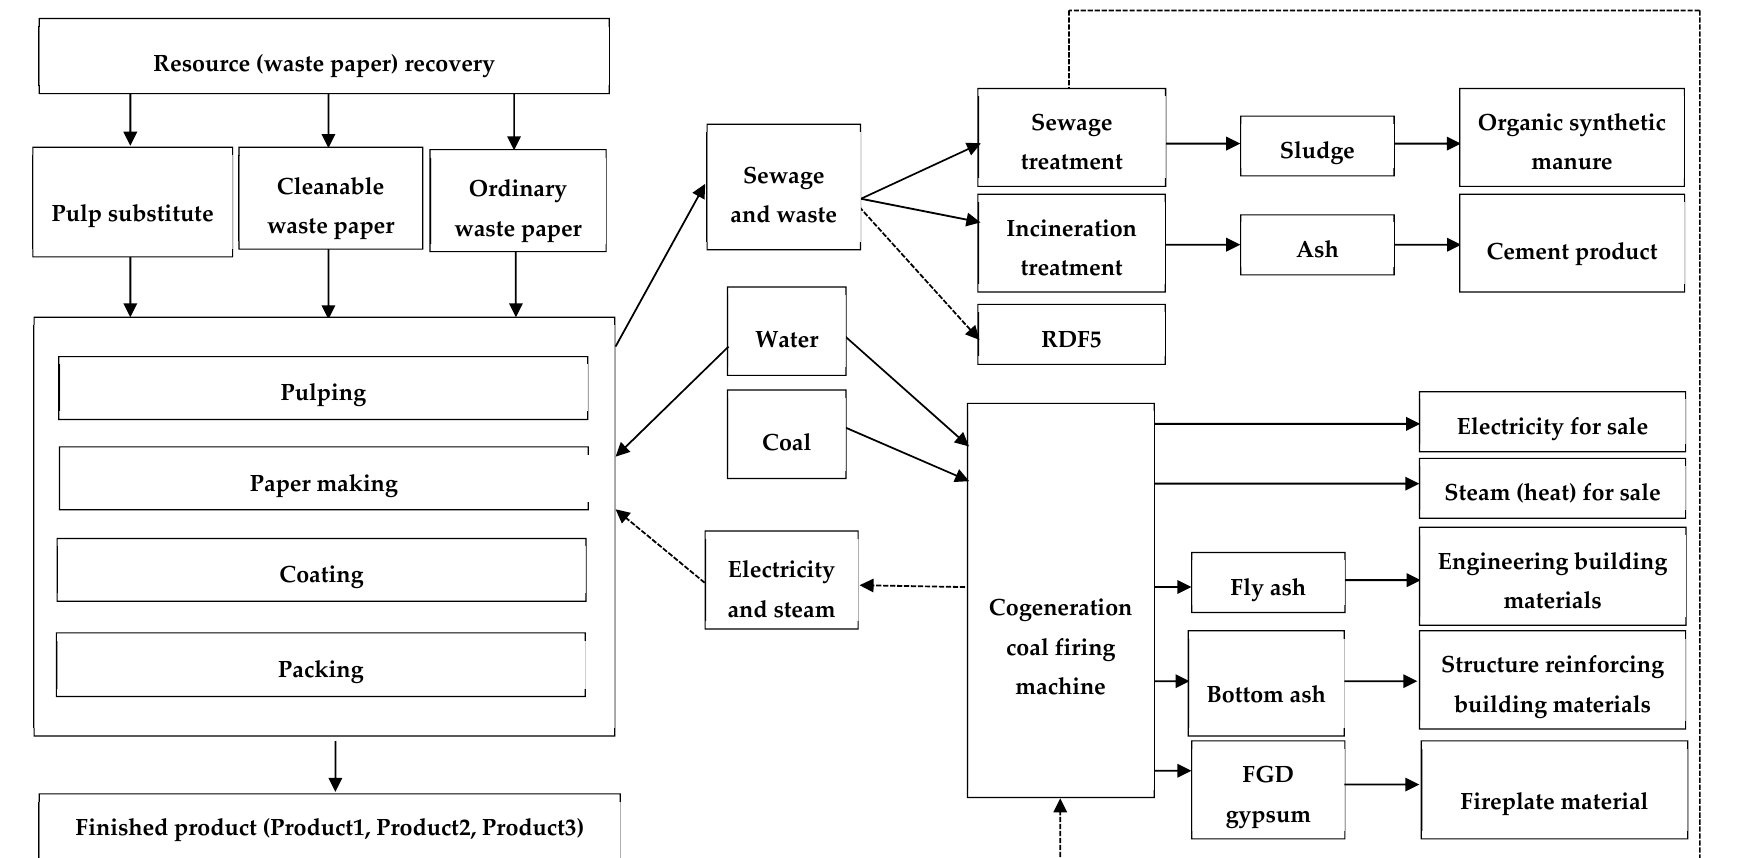
Figure 4. Manufacturing process of Company A.